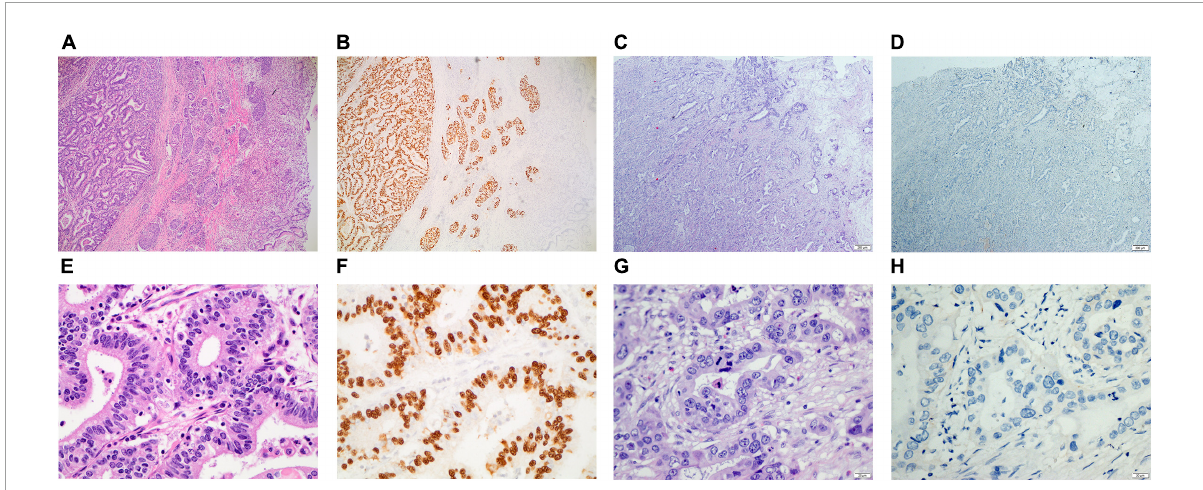
FIGURE1 Eosin hematoxylin staining and In situ hybridization of EBERs for the primary tumor tissue of gastric cancer with or without EBV infection. (A,B) for the gastric cancer with EBV infection ( × 40); (C,D) for the gastric cancer without EBV infection ( × 40); (E,F) for the gastric cancer with EBV infection ( × 400); (G,H) for the gastric cancer without EBV infection ( × 400).